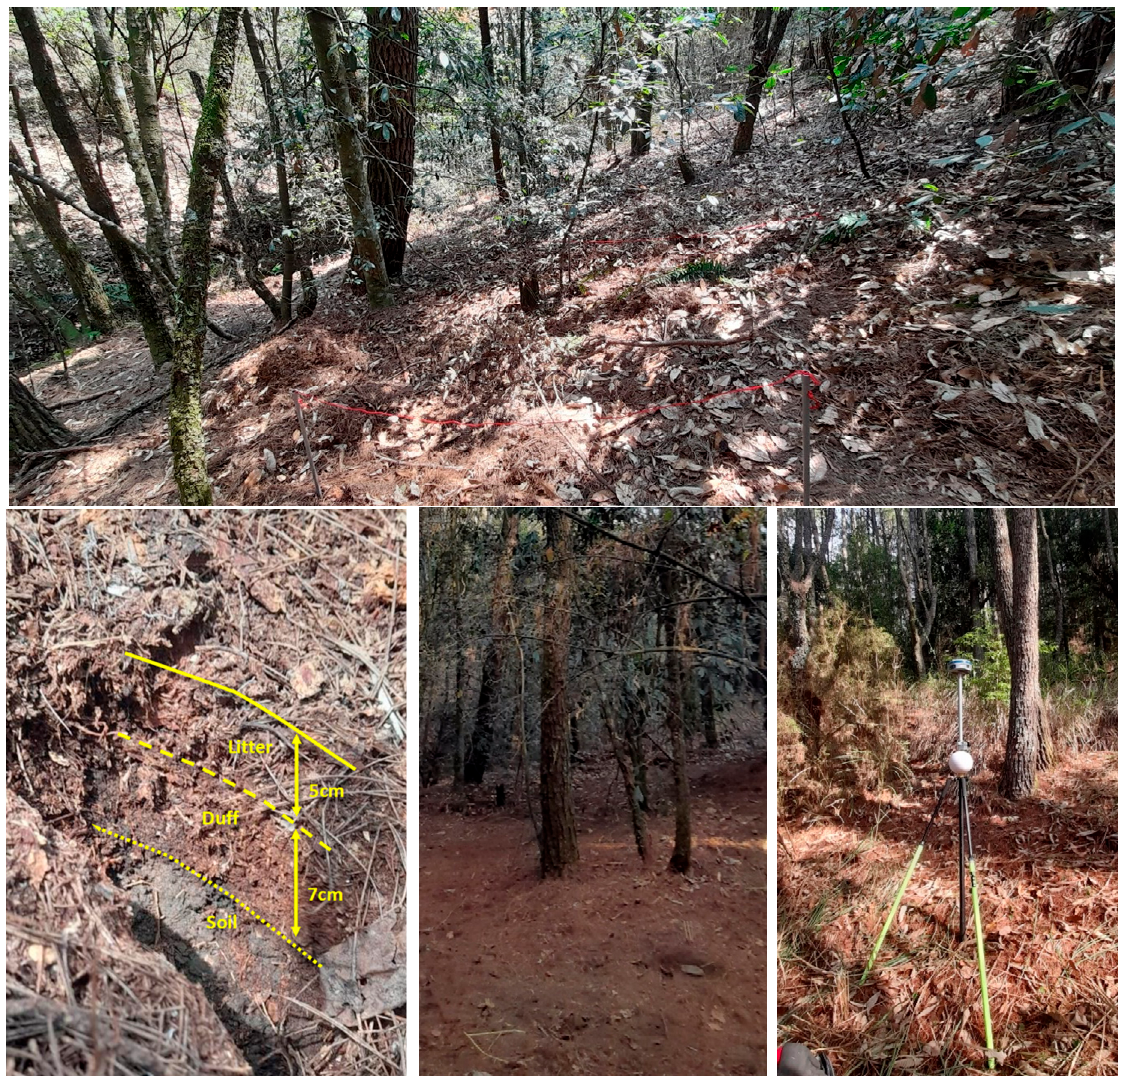
Figure 5. A site scene of a post-hoc field survey plot for the surface fuel model performance determination. The upper image displays surface fuel distributed over a pine stand mixed with a few broadleaf saplings and juveniles. The images to the lower left present a profile of litter/duff/soil in the plot, and those in the center to the lower middle show the cleared ground of the subplot area (10 m by 10 m) after the surface fuel collection. The image to the lower right shows the integrated control point for the VBS-RTK positioning and terrestrial mobile lidar scanning with a ZEB Horizon.